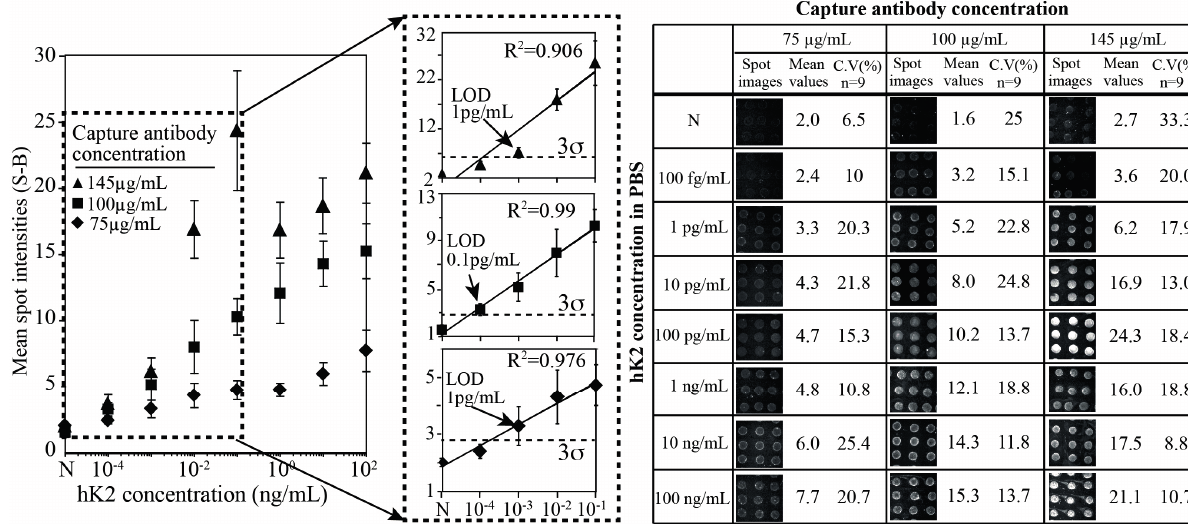
Figure 3. Titration series of hK2 in buffer (PBS) solution at three different concentrations of the capturing antibody 6B7 (75 µg/mL, 100 µg/mL and 145 µg/mL). The LOD was found to be 1 pg/mL when the capturing antibody was 75 µg/mL and was reduced to 100 fg/mL when the capturing antibody concentrations were 100 µg/mL. The LOD became 1 pg/mL again when concentration of the antibody was 145